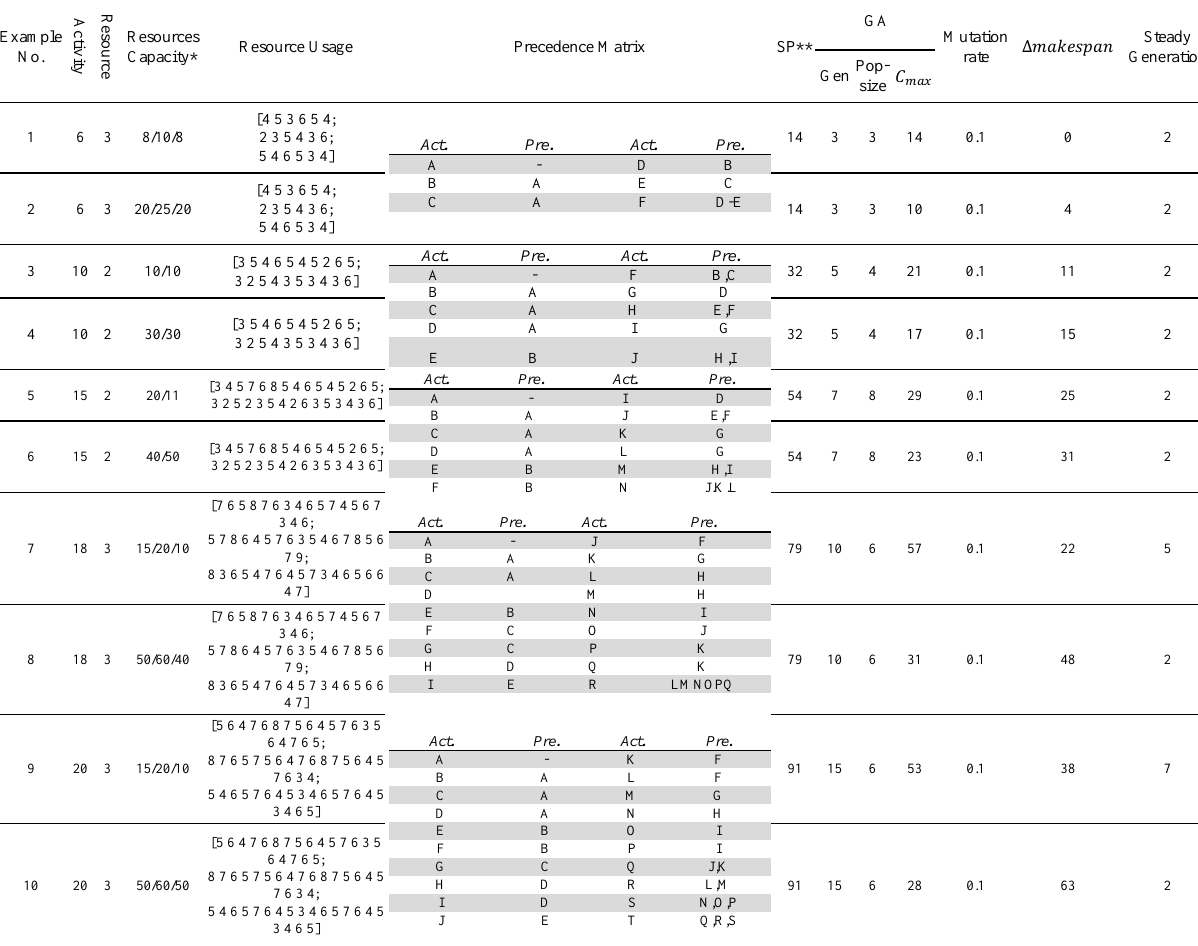
Numerical Examples for the Proposed Backward-forward